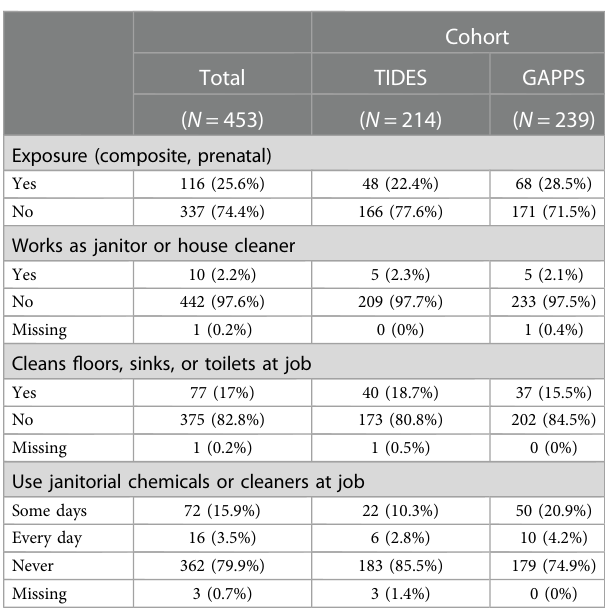
TABLE 2 Occupational exposure to cleaning chemicals a among pregnant individuals in the study